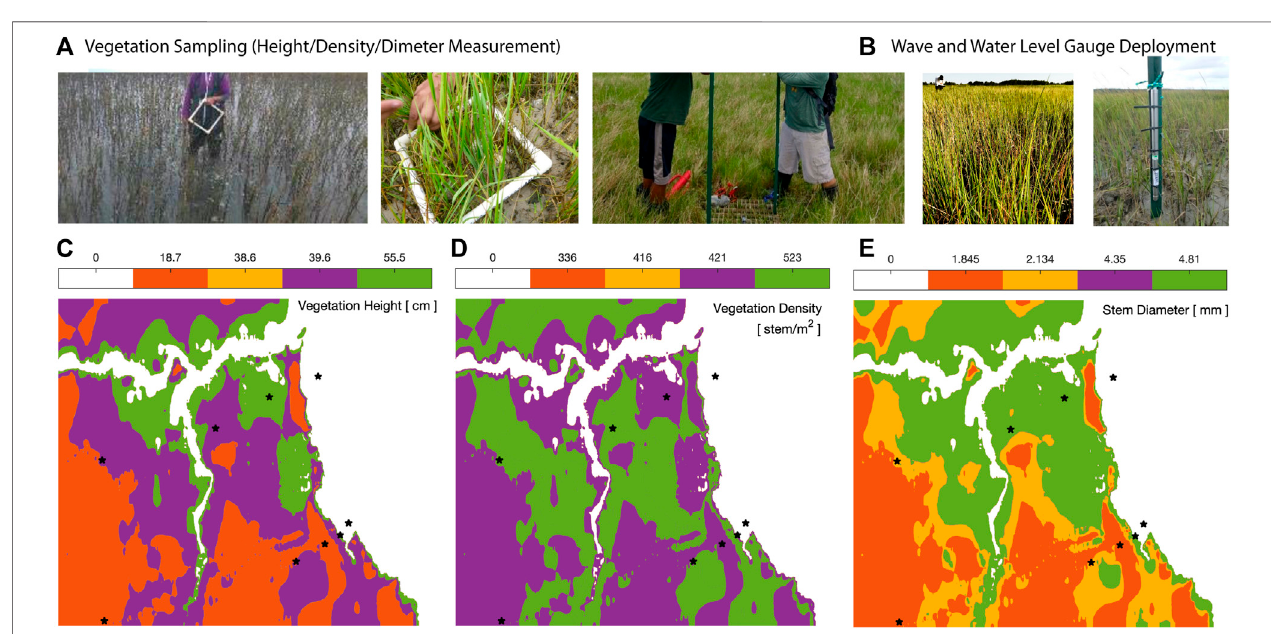
FIGURE6 | Field measurementsfor vegetation sampling (A) and wave and water level gauges deployment/survey (B) . Spatial distribution ofvegetation height (C) , vegetation density (D), and stem diameters (E) in Magothy Bay.